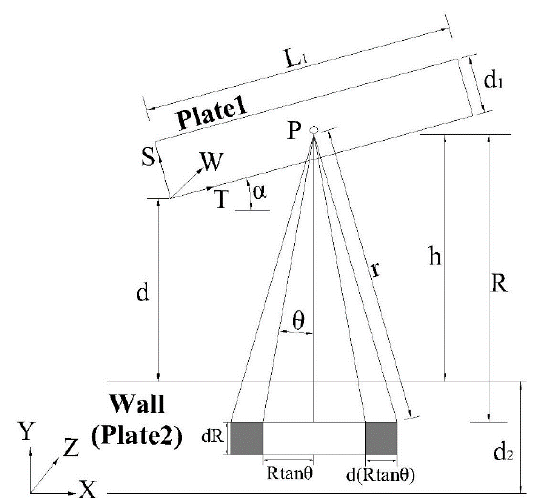
Figure 2. Schematic diagram of the ideal plate-wall system.